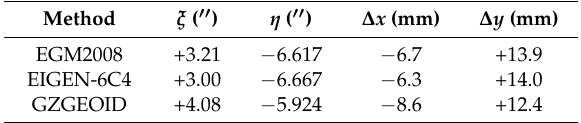
Table 8. The vertical deflections and the corrections of plane coordinates calculated with different strategies.